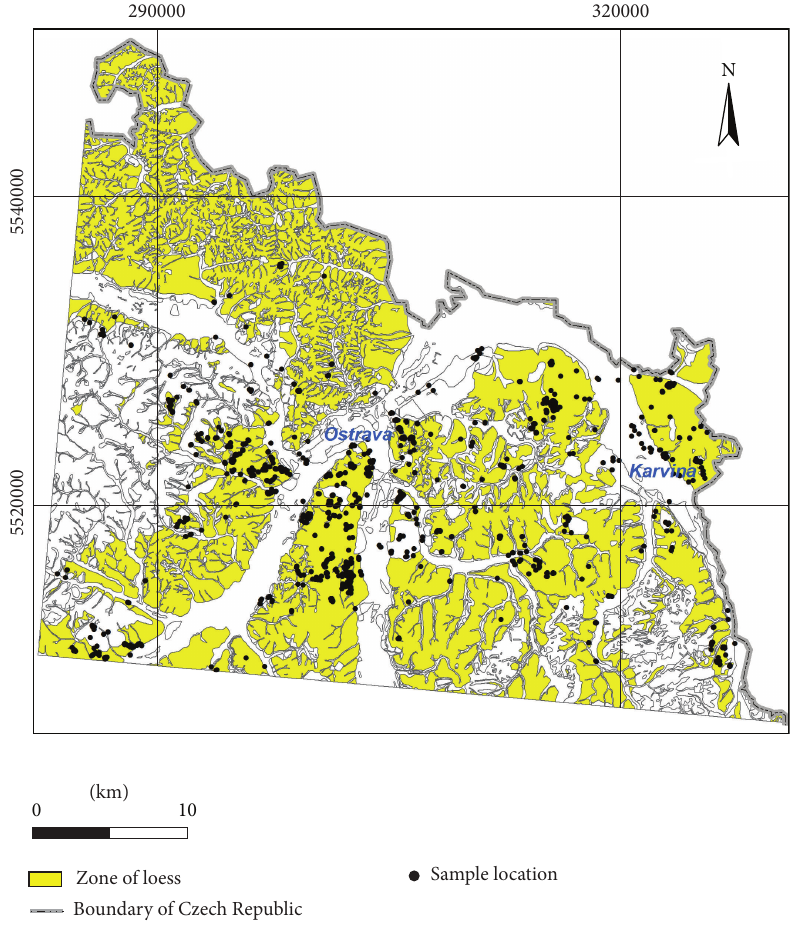
Figure 1: Polygenetic loess sediments in the area of